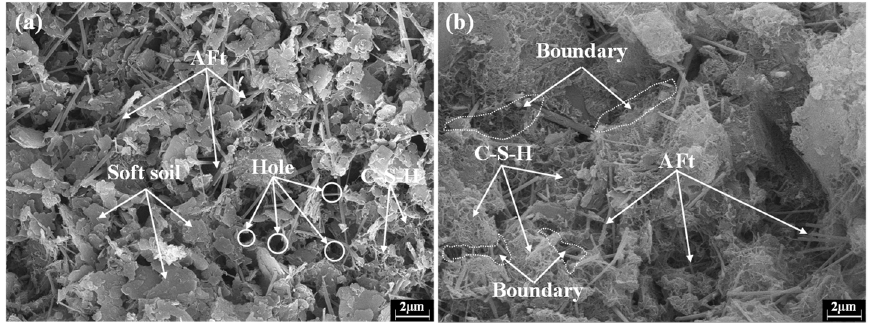
Figure 10. Micro-morphology of core samples of different types of solidifying materials in deep mixing piles: ( a ) cement and ( b ) solidifying agent. mixing piles: ( a ) cement and ( b ) solidifying